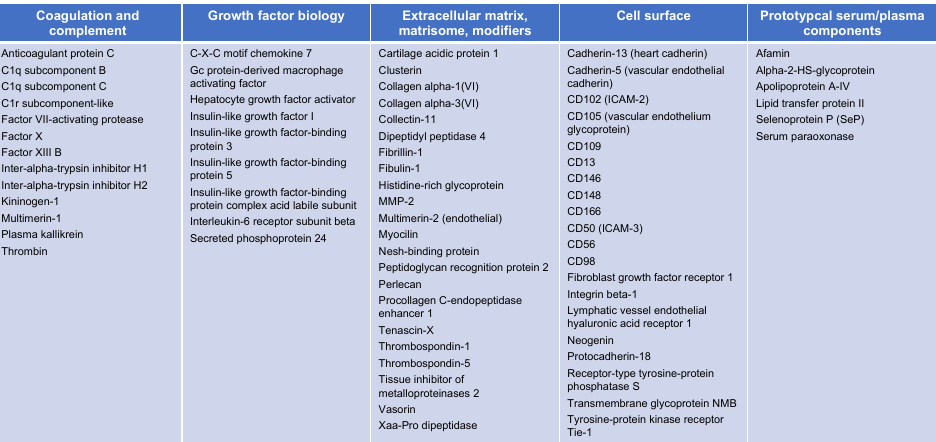
Figure 5. Exemplary annotation of proteins whose abundance negatively correlates with diseases severity as determined by clust analysis [18].